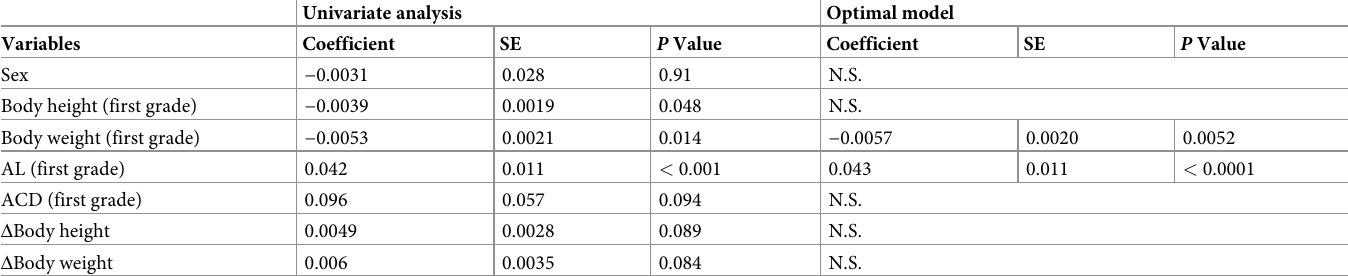
Table 2. The relationships of change in the AL with sex, body height (first grade), body weight (first grade), ACD (first grade), AL (first grade), Δ body height, and Δ body weight.